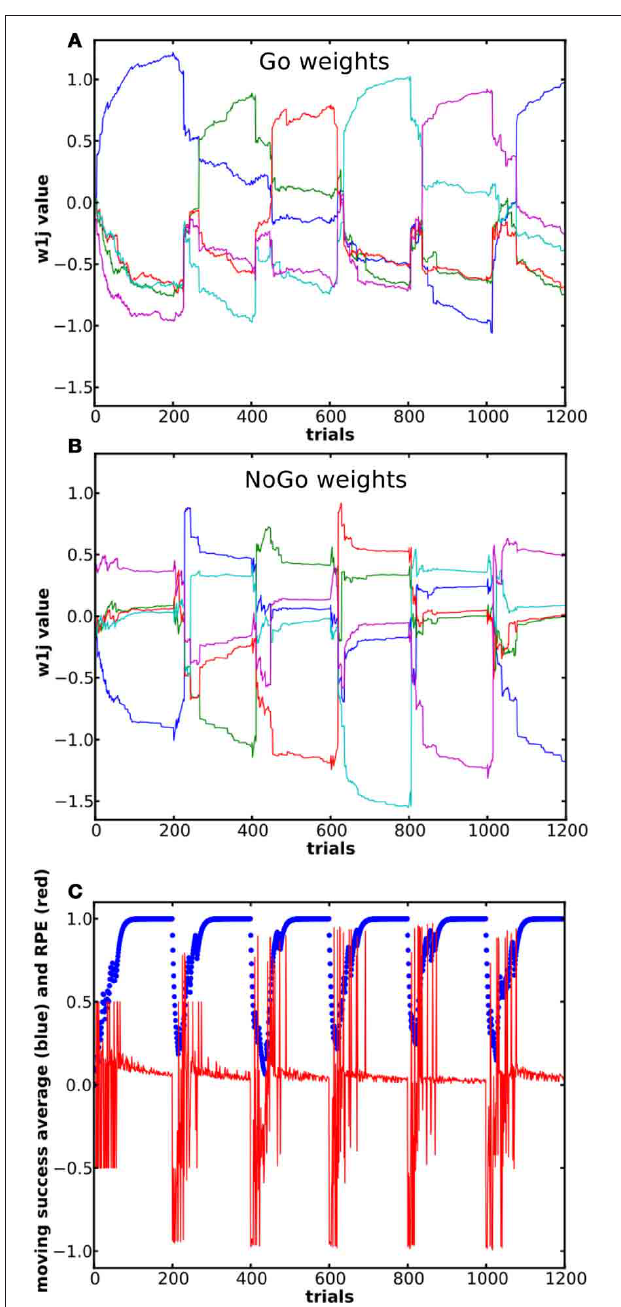
FIGURE 5 | Dynamics of the weights and of the RPE during a successive learning task. Each block consisted of 500 trials. 6 blocks were presented, so that the reward mapping for block 1 and block 6 was the same. Panels (A) and (B) show Go and NoGo weights from state 1 to the 5 actions. Same color in the two panels represents connections to the same action. (C) In blue, moving average of reward over the last 10 trials. In red is shown the